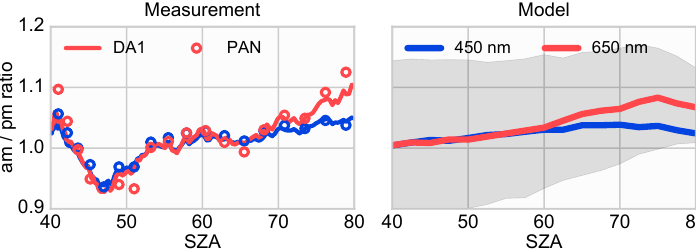
Figure 6. Measured and modelled am–pm ratios at the coast for 450 and 650nm as a function of SZA. AOD variations during the day cause the measured ratios to fluctuate. The grey band indicates the maximum variability of the ratio due to an AOD difference of 0.01 (Ångström β) between morning and afternoon for 650nm. Note the splitting of the ratios between the two wavelengths at around 65 ◦ SZA, characteristic for the ocean’s sun glint at high SZA.